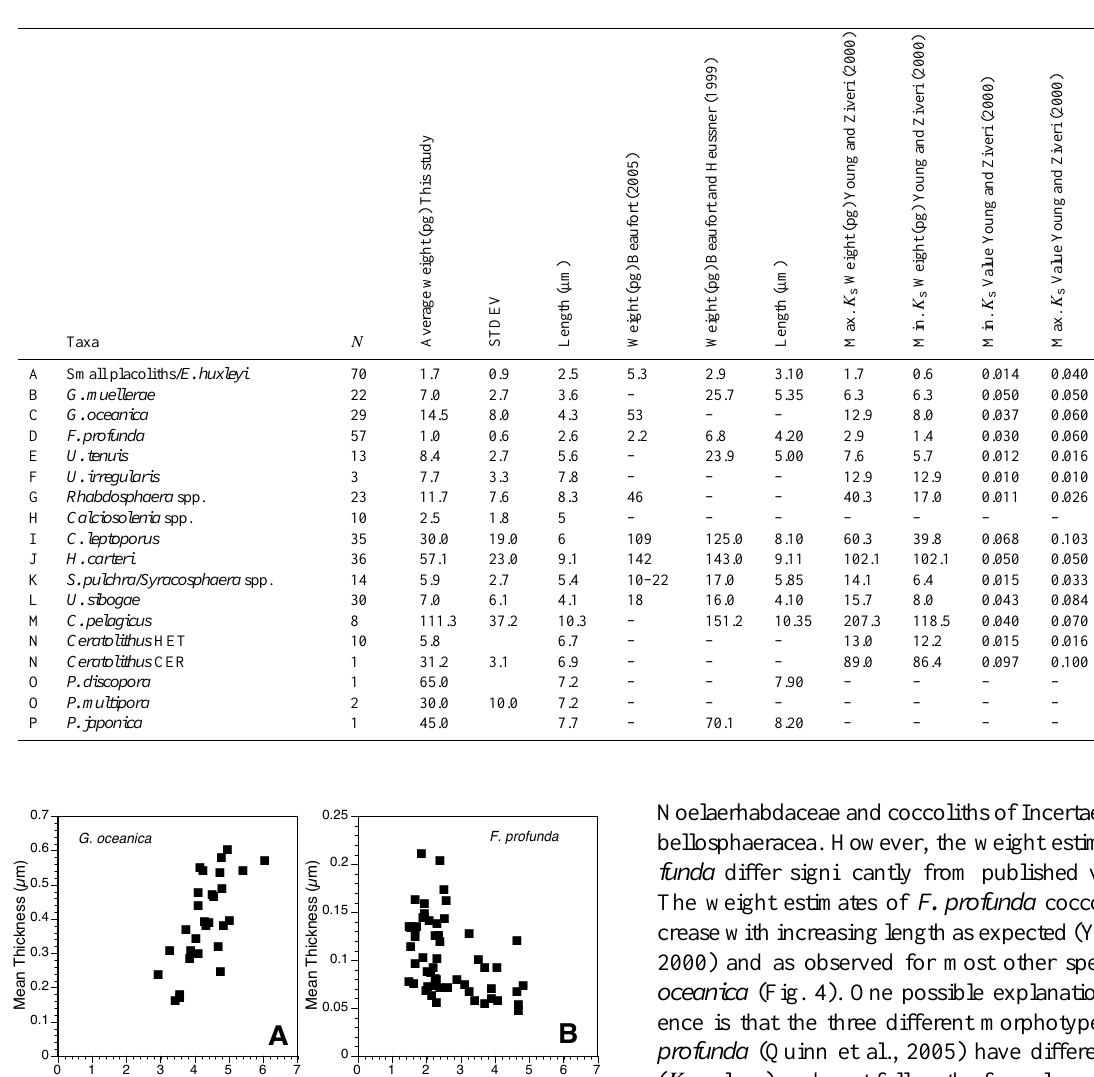
Table 1. Comparison of published weight estimates. N = Number of measurements; STDEV=Standard deviation of weight estimates re- ported; K s = shape factor reported by Young and Ziveri (2000). Values for maximum length of single coccoliths for E. huxleyi were re- ported by Bollmann and Herrle (2007), for Gephyrocapsa spp. by Bollmann (1997) and Bollmann et al. (2010), for F. profunda by Quinn et al. (2005), for C. leptoporus by Knappertsbusch et al. (1997), for C. pelagicus by Parente et al. (2004). Values for all other species were taken from Young and Ziveri (2000). Please note that the average length for populations are significantly smaller, for example, for E. huxleyi the maximum average length of a Holocene sample is smaller than 4µm although the maximum size of a single coccolith can be up to 6µm (Bollmann and Herrle, 2007).